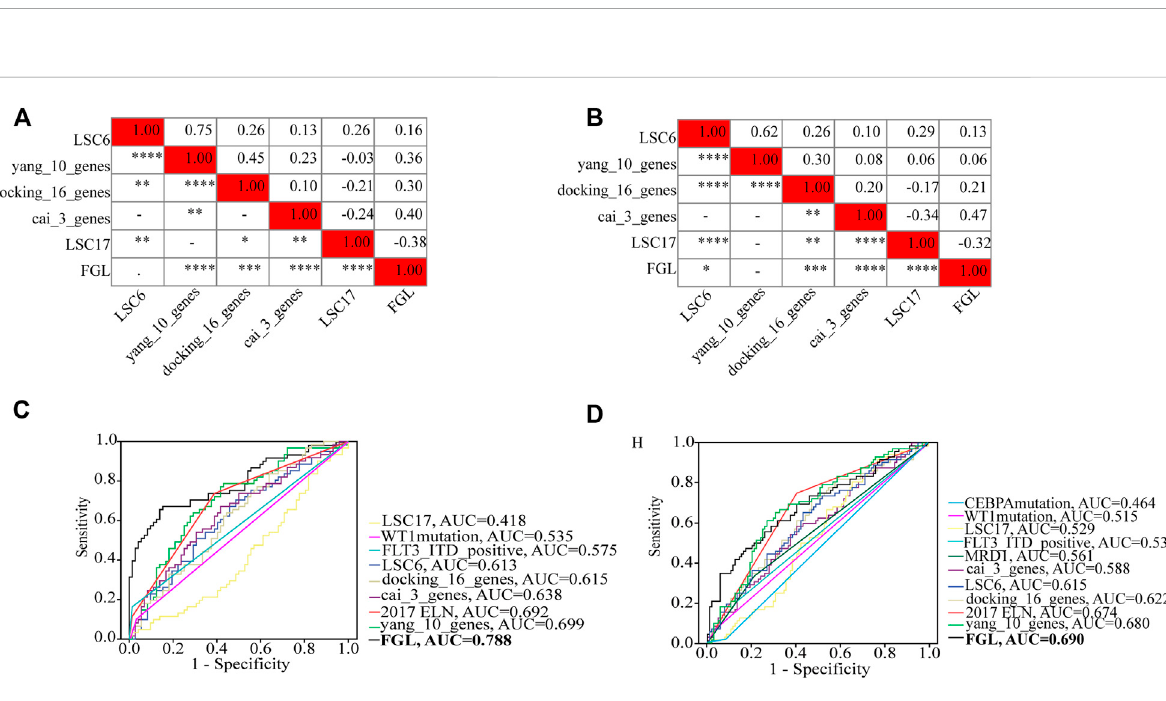
Frontiers in Molecular